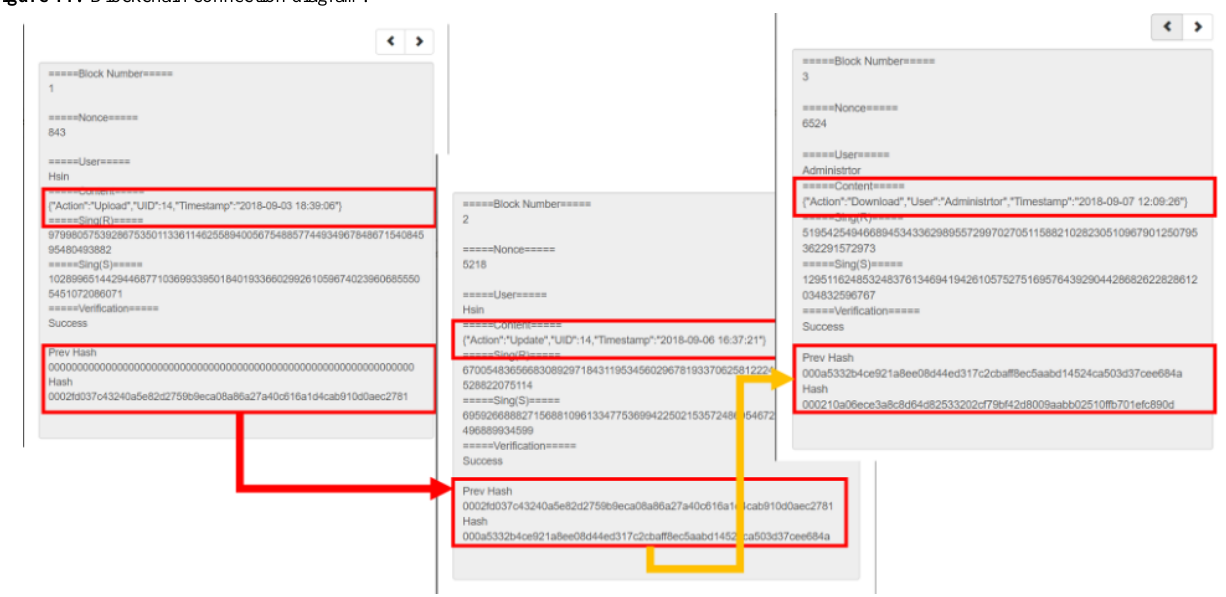
Figure 11. Blockchain connection